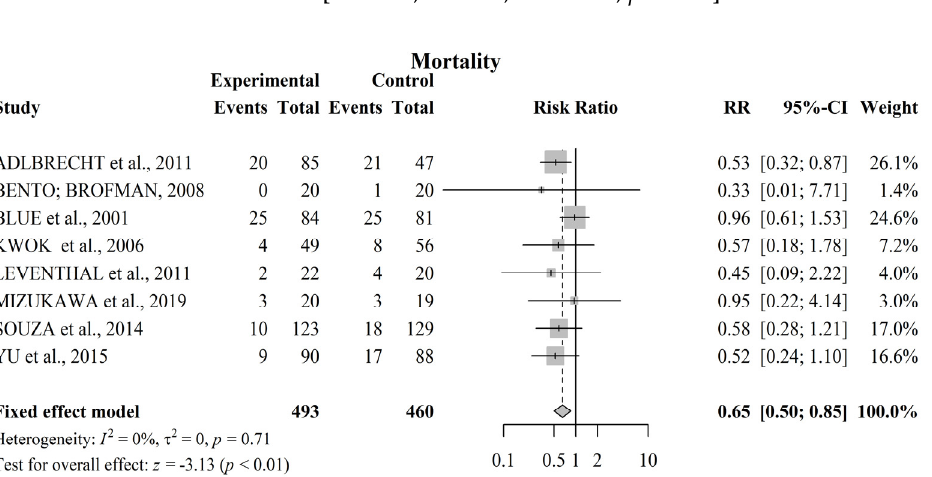
Figure 3. Forest plot of the effect of educational nursing interventions on reducing mortality in patients with HF. The meta-analysis identified a 35% reduction in mortality in the IG [RR 0.65, 95% CI, 0.50 − 0.85. References involved in the study: [12–17,20,22].